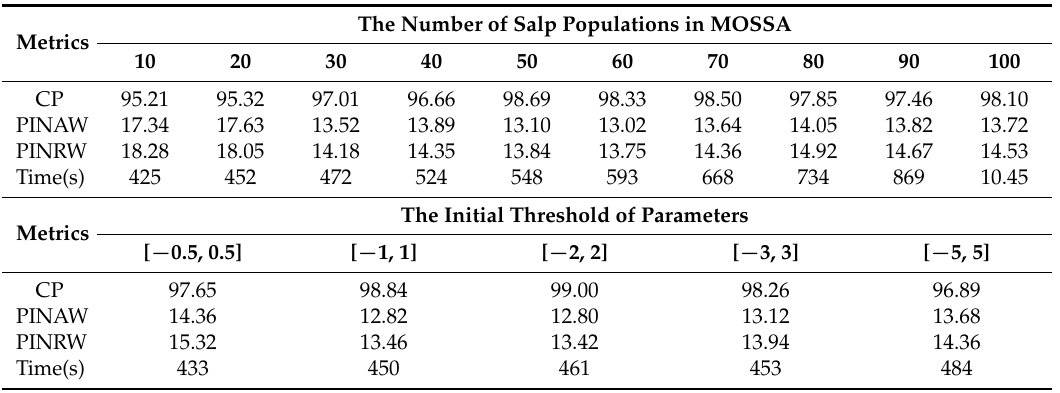
Table 6. Sensitivity analysies results of different hyper-parameters.